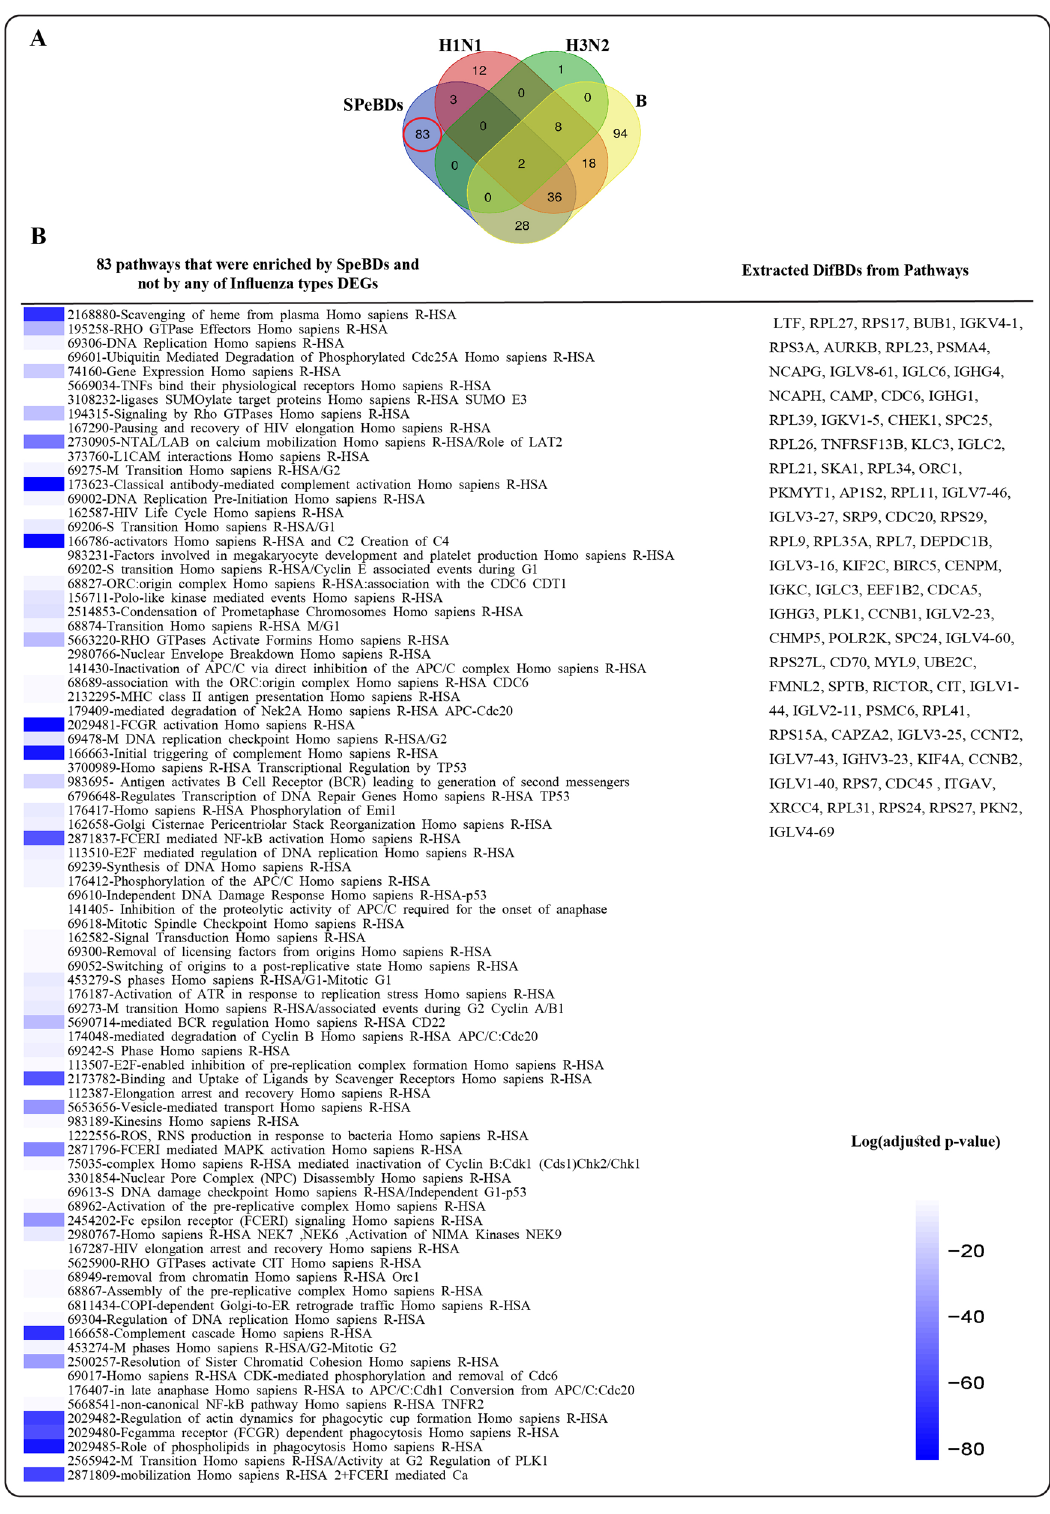
Figure 4. ( A ) Venn diagram representing the pathways enriched by SpeBDs, Influenza H1N1 PB DEGs, Influenza H3N2 PB DEGs, and Influenza B PB DEGs constructed using an online tool available at https:// bioin forma tics. psb. ugent. be/ webto ols/ Venn/. The red circle mentions pathways that were enriched by SpeBDs and not by the three Influenza types; these pathways are listed in part B: Eighty-three pathways were obtained from pathway enrichment analysis of SpeBDs and were different from pathways obtained by pathway enrichment analysis of Influenza H1N1, H3N2, and B DEGs; ( B ) is created using RStudio version 2022.12.0 and Adobe Illustrator version